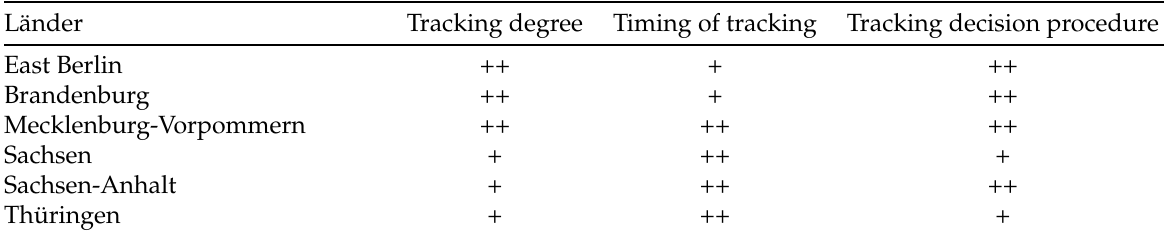
Table 1: Institutional changes (until 2004) and predicted development of social inequality in educational